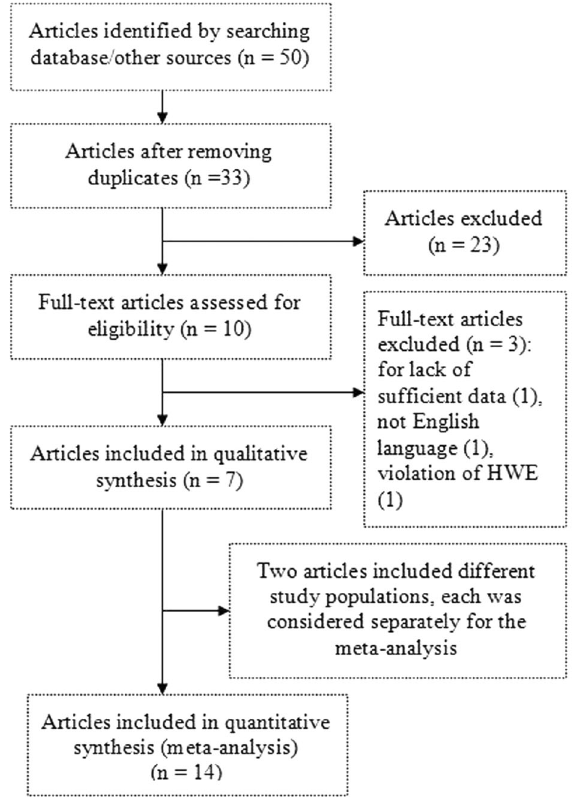
Figure 1. Flow diagram of study.